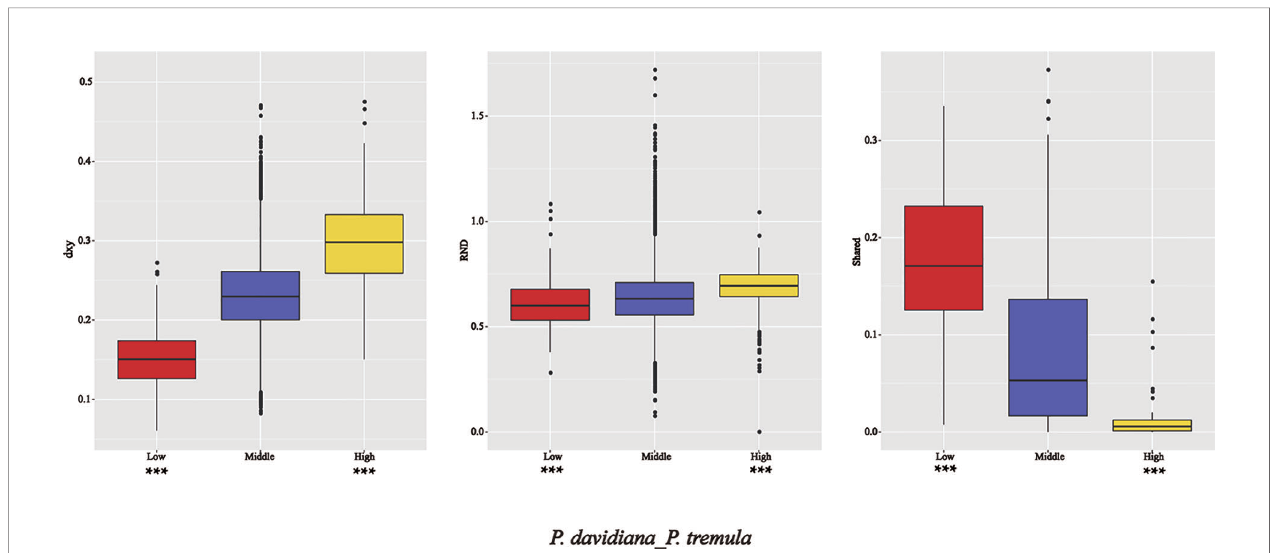
FIGURE 7 | Comparisons of dxy, RND and shared among regions displaying signi fi cantly high (yellow boxes) and low (red boxes) differentiation versus the genomic background (blue boxes) between P. davidiana and P. tremula.